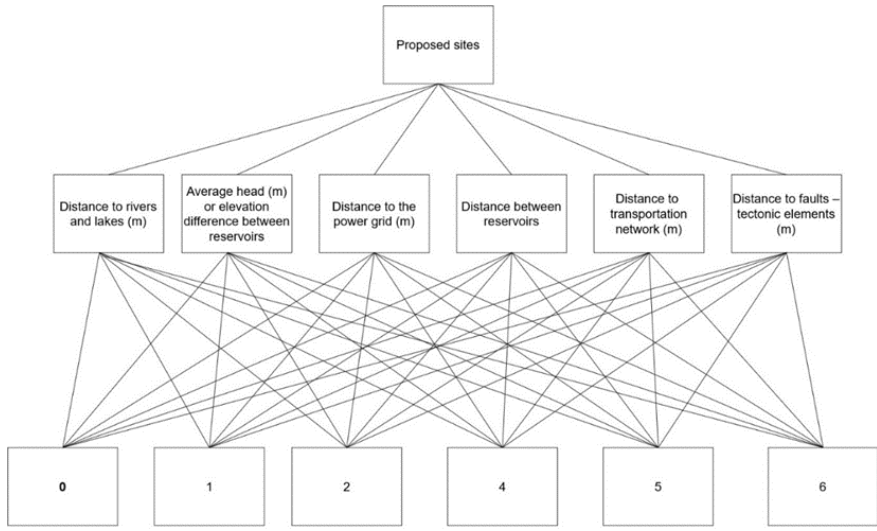
Figure 9. Hierarchy structure for upper reservoir site selection. Table 4. Saaty’s scale of importance intensities